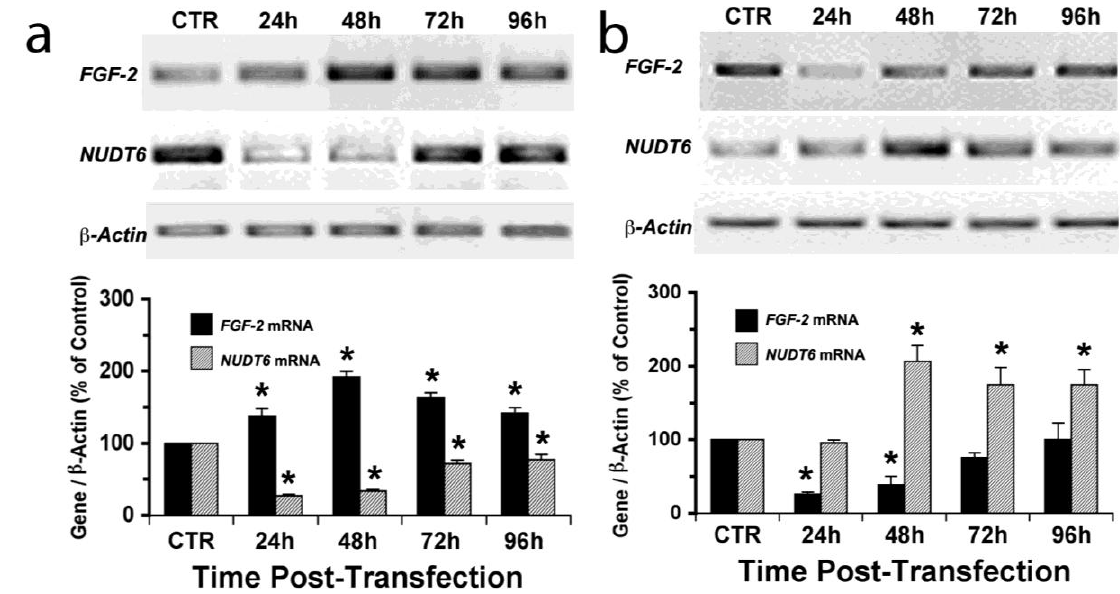
Figure 2. Time course of siRNA knockdown of FGF2 and NUDT6 mRNA. C6 glioma cells were transfected with 100 nM of NUDT6 siRNA ( a ), FGF2 siRNA ( b ), or a